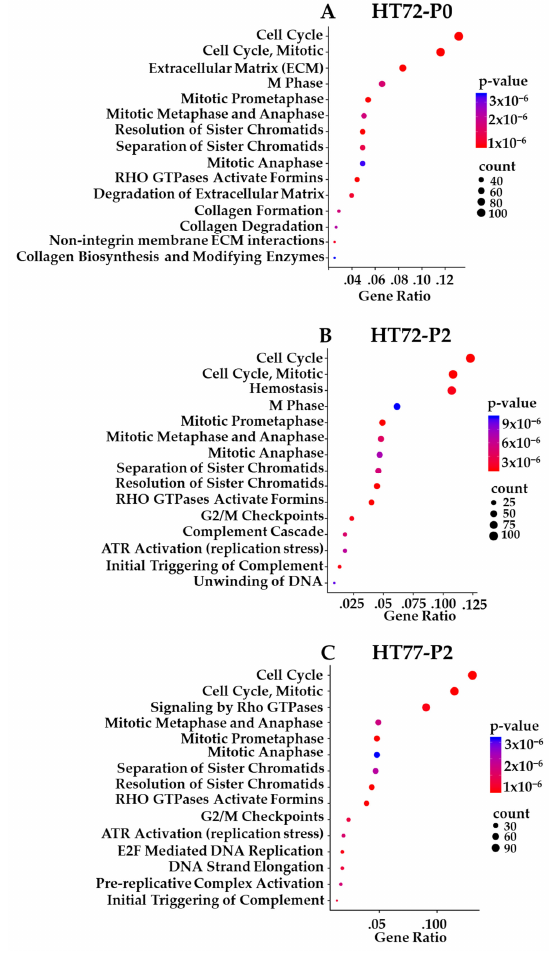
Figure 11. In ( A ) HT72-P0, ( B ) HT72-P2, and ( C ) HT77-P2, cell cycle pathway is identified as key player following pathway enrichment analyses of transcriptome. Genes that were statistically sig- nificant ( p < 0.05) and >1.5-fold change were selected for pathway enrichment analysis using GO, KEGG, and Reactome.